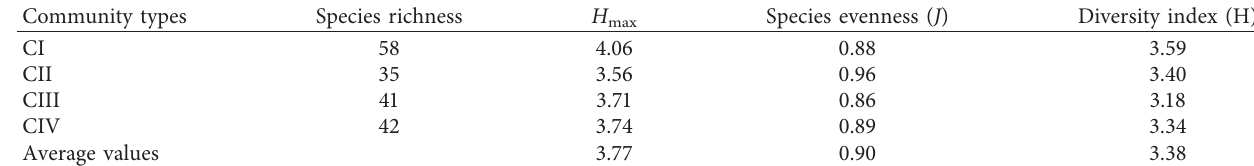
Table 4: Shannon–Weiner diversity, species richness, and species evenness of the plant community.